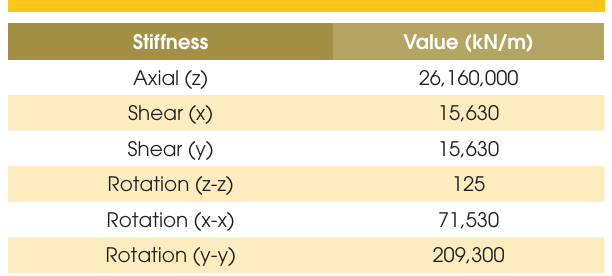
Table 4 – Support device’s